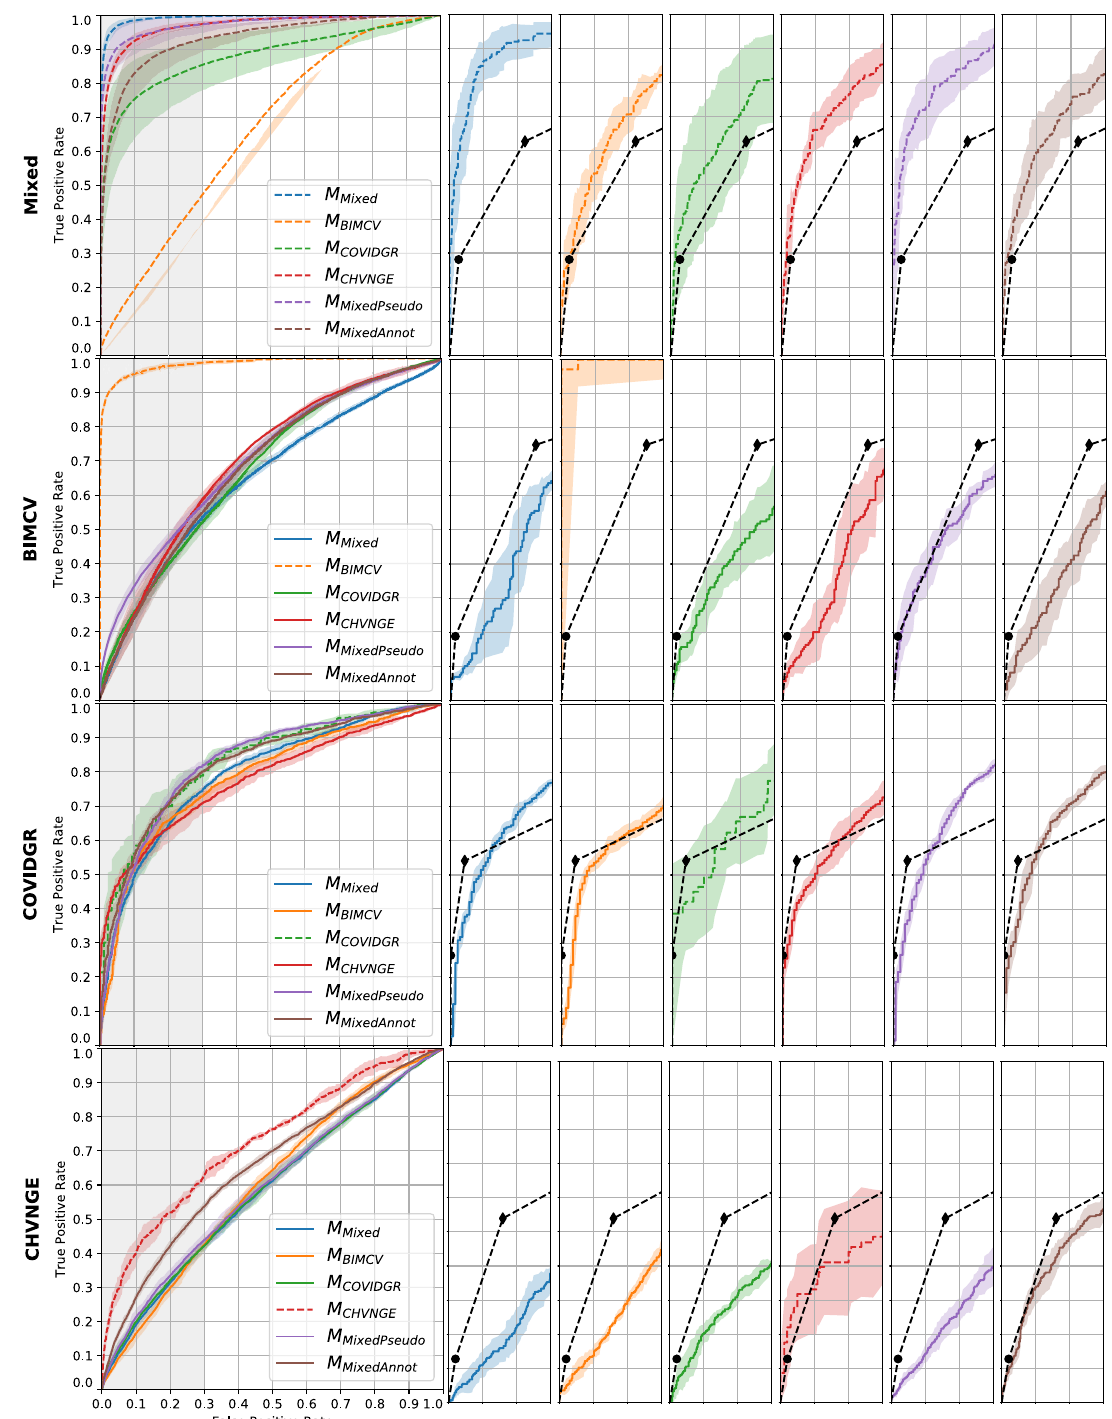
Figure 4. ROC of each of the models on each of the datasets. Average model performance across all folds is shown as a line (full line: full dataset used for testing; dashed line: separate test set for each fold) and shaded region corresponds to the 95% confidence interval. Left: model performance on all CXRs; Right: model and radiologists performance on annotated CXRs. Rightmost plots are a zoomed version of the gray shaded region of the left plot. Radiologists performance is shown when considering as positives only CXRs marked as Indicative of COVID-19 ( • ) or Indicative of COVID-19 and Undetermined ( (cid:31)